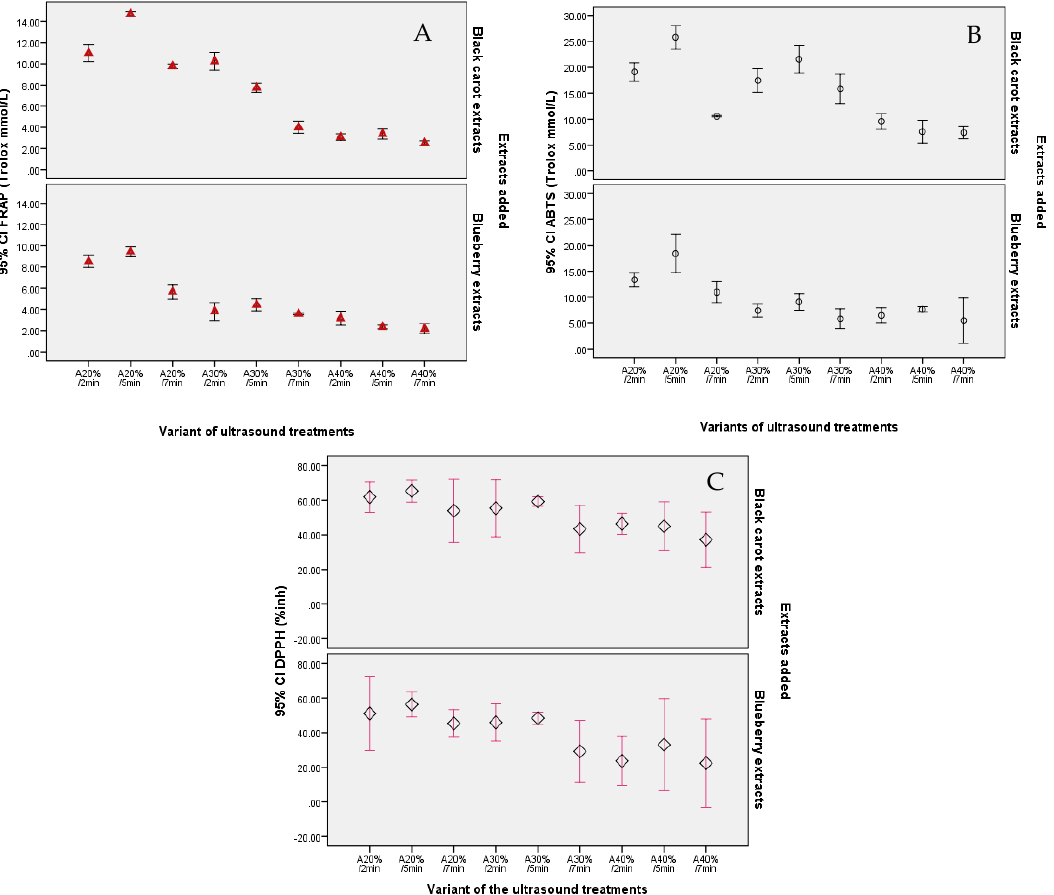
Figure 4. Effects of the ultrasound treatments and of extracts additions (for obtaining cider enriched with antioxidants) on FRAP assay results (mmol TE / L). ( A ) ABTS assay results (mmol TE / L); ( B ) DPPH inhibition %; ( C ) of the cider variants obtained. Data are means of three experiments (n = 3). CI—confidence intervals of means.